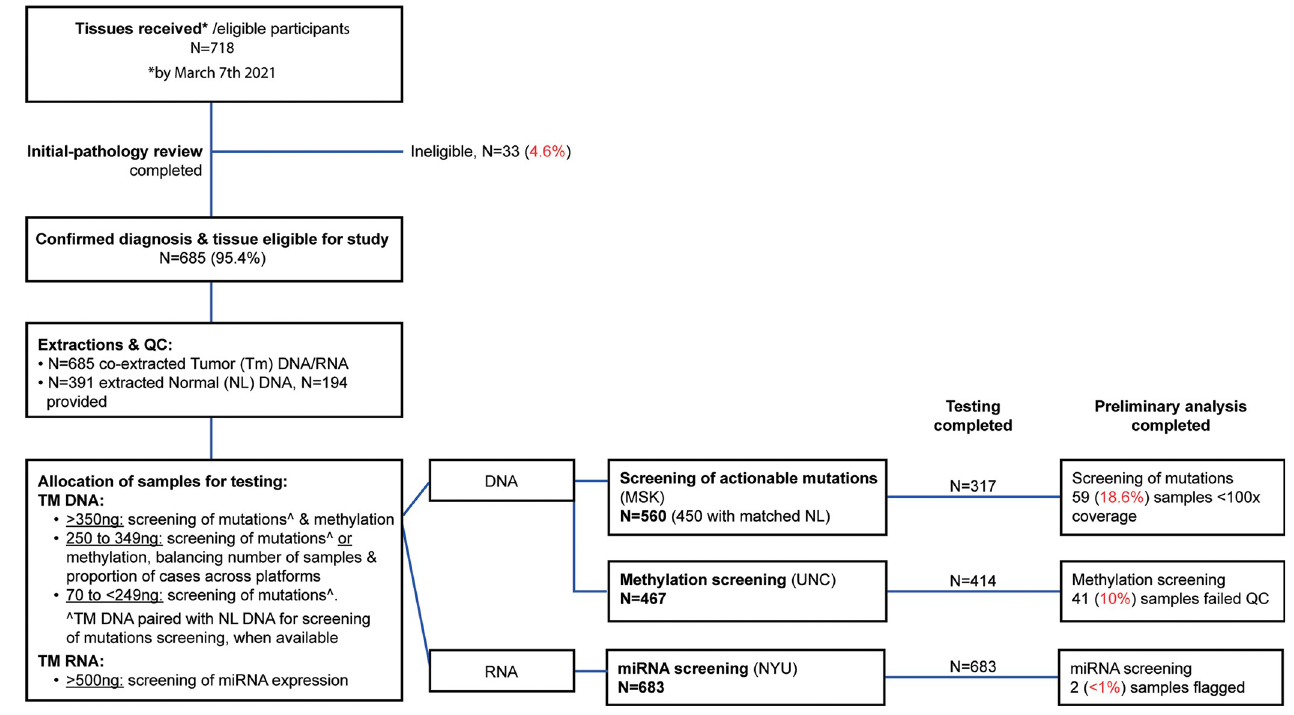
Fig 4. Biospecimens received, processed, and distributed for